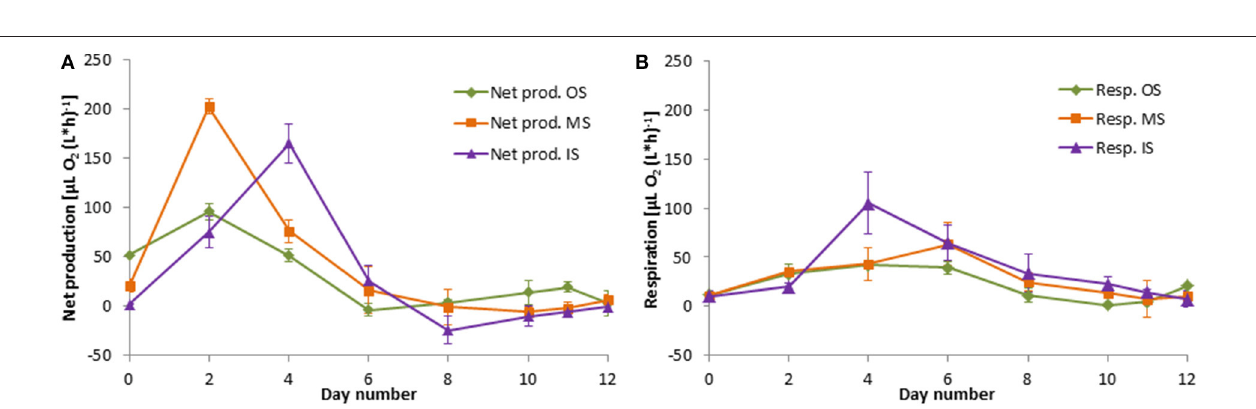
FIGURE 11 | Development of the net community production (A) and respiration rates (B) in the tanks of the experiment from summer 2014. Mean values and standard deviations of the three replicate tanks are shown.